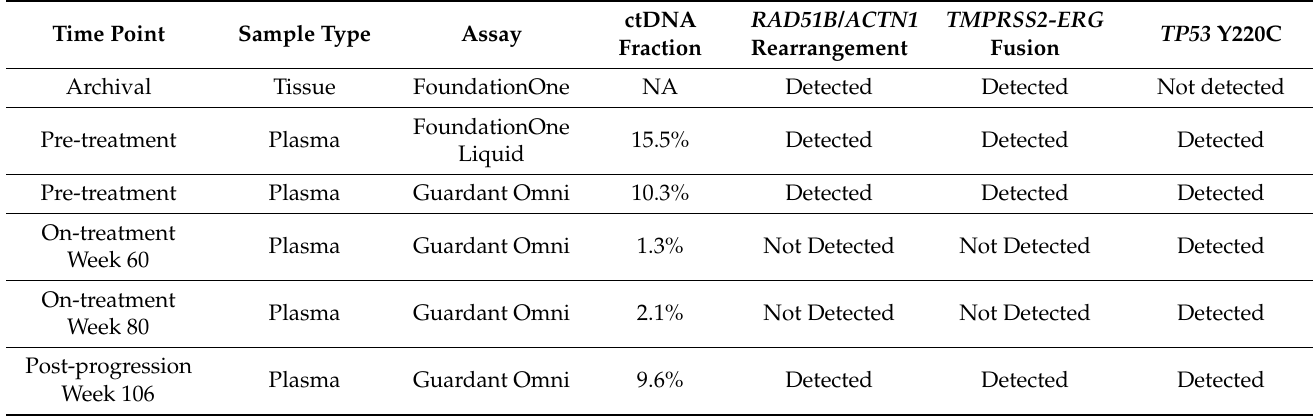
Table 1. Summary Of Longitudinal Genomic